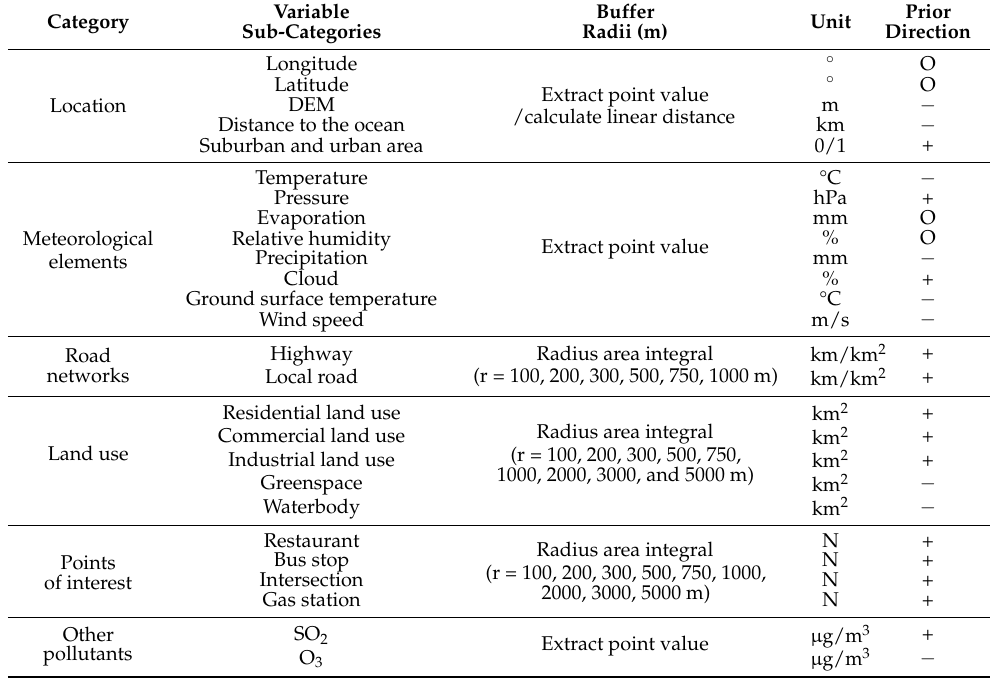
Table 1. Independent